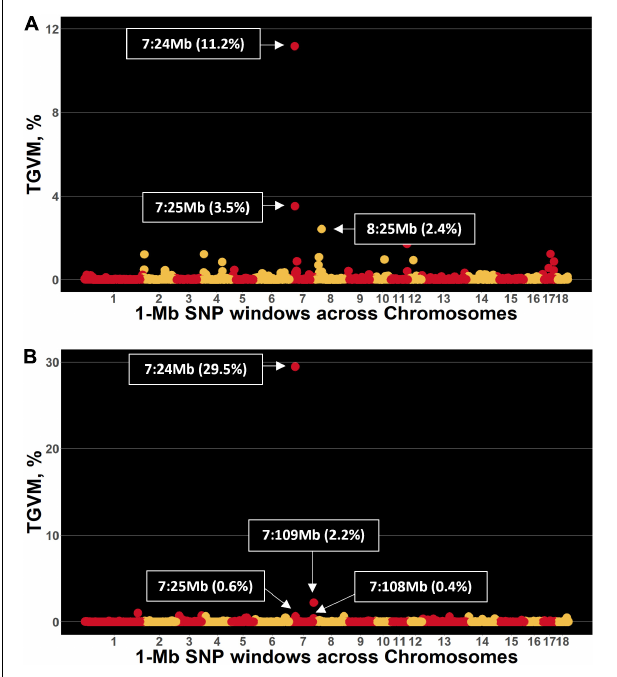
FIGURE 1 | Manhattan plot for sample-to-positive (S/P) ratio during the porcine reproductive and respiratory syndrome (PRRS) outbreak in Duroc and Landrace sows. Each point represents a 1-Mb SNP window ( x -axis) plotted against the percentage of total genetic variance accounted for by markers (TGVM; y -axis). (A,B) Results for Duroc and Landrace sows,